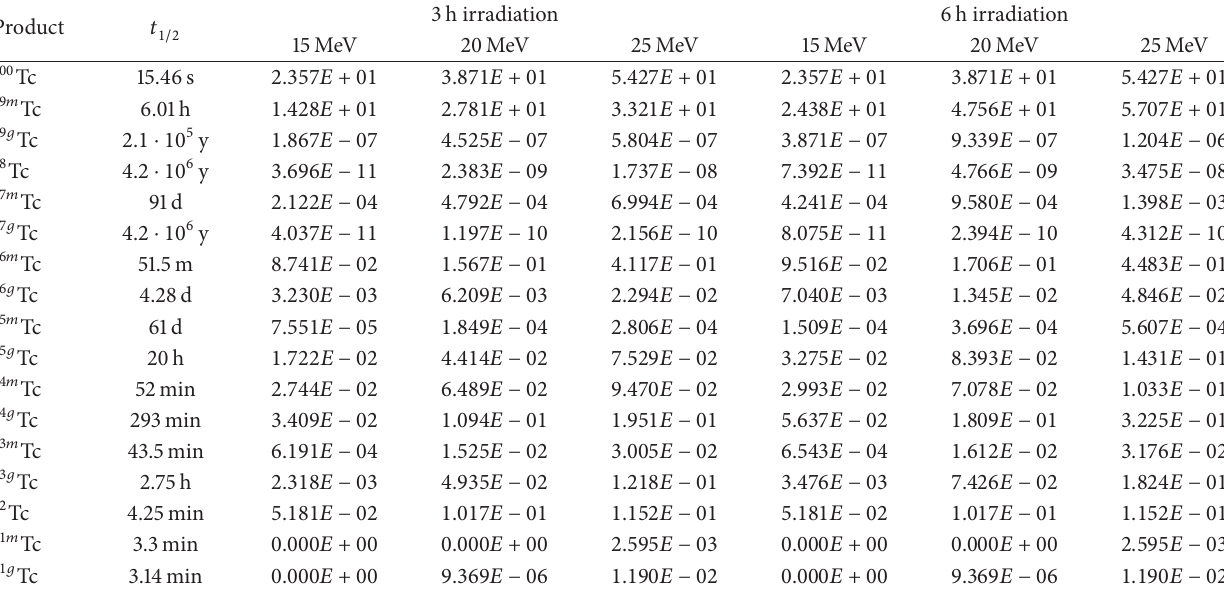
Table 5: The calculated integral yields (mCi/ 𝜇 A) at EOB after 3 and 6 hours irradiations for the expected Tc radioactive species inside the target. 99.05% 100 Mo-enriched metallic molybdenum in the optimized target configuration irradiated at 15, 20, and 25 MeV is considered. The whole list of all Mo, Nb, and Zr radioactive yields is not reported here for the sake of